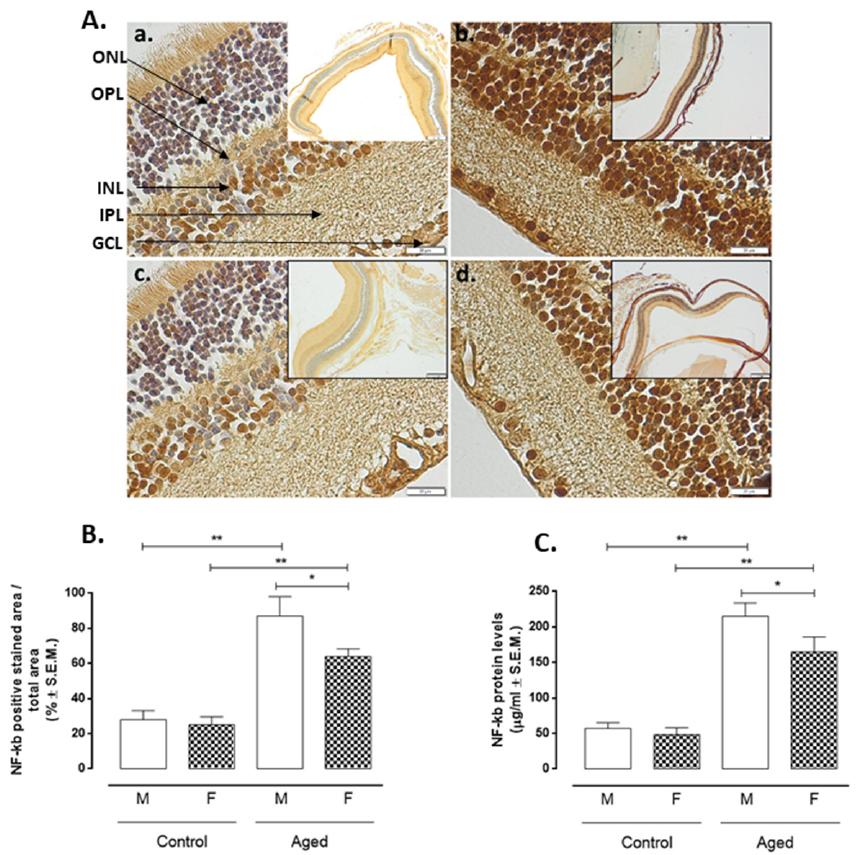
Figure 4. NF-kB expression in aged and younger (control) retina. ( A ) Representative immunohisto- chemistry (a. control male; b. aged male; c. control female; d. aged female) and ( B ) quantification of immunopositive areas in control and aged retina (M: males and F: females); the results calculated as the % ± S.E.M. are considered statistically significant when * p < 0.05; ** p < 0.01 vs. control; n = 10 observations for each individual/group; ONL: outer nuclear layer; OPL: outer plexiform layer; INL: inner nuclear layer; IPL: inner plexiform layer; GCL: ganglion cell layer; Panel A: bar = 20 µ m. The frames in the panel A are given on the right in a lower magnification bar = 200 µ m; ( C ) enzyme-linked immunosorbent assay (ELISA) of NF-kB protein levels in the control and aged retina; results are expressed as the mean ± S.E.M. of n = 10 retinas per group. DU: densitometric units; ** p < 0.01; * p < 0.05 vs. control.